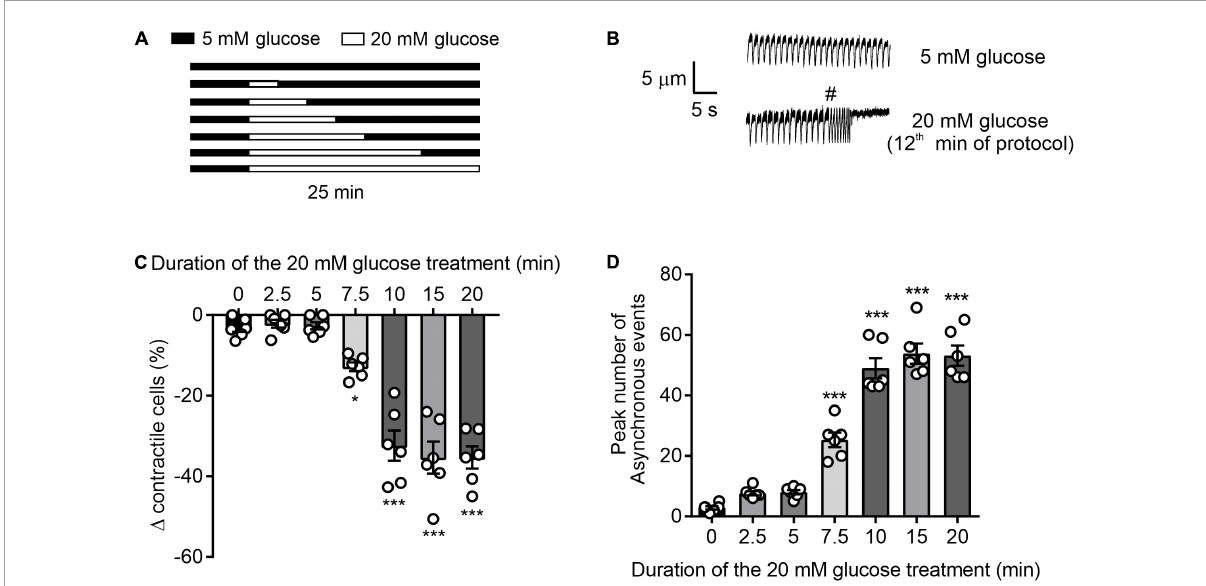
FIGURE1 Time course of glucose-induced dysregulation of cardiomyocyte contractile function. (A) Illustration of the experimental design used in this figure. (B) Example traces showing cardiomyocyte contractions, initiated by 1 Hz EFS, in the presence of 5 or 20 mM glucose. Cardiomyocytes that contracted outside of the 1 Hz EFS, as demonstrated by # in panel B , or failed to contract were not defined as contractile cells. Therefore, only cardiomyocytes that contracted in time with 1 Hz EFS were counted as contractile cells. (C) Bar chart showing the mean percentage change in contractile cells (* p < 0.05, *** p < 0.001. One Way ANOVA with Holm-Sidak post-test). (D) Bar chart showing the mean number of arrhythmic episodes in each data set. *** p < 0.001 One-Way ANOVA with Holm-Sidak post-test. n = 6 experiments from six animals ( > 98 cells for each data